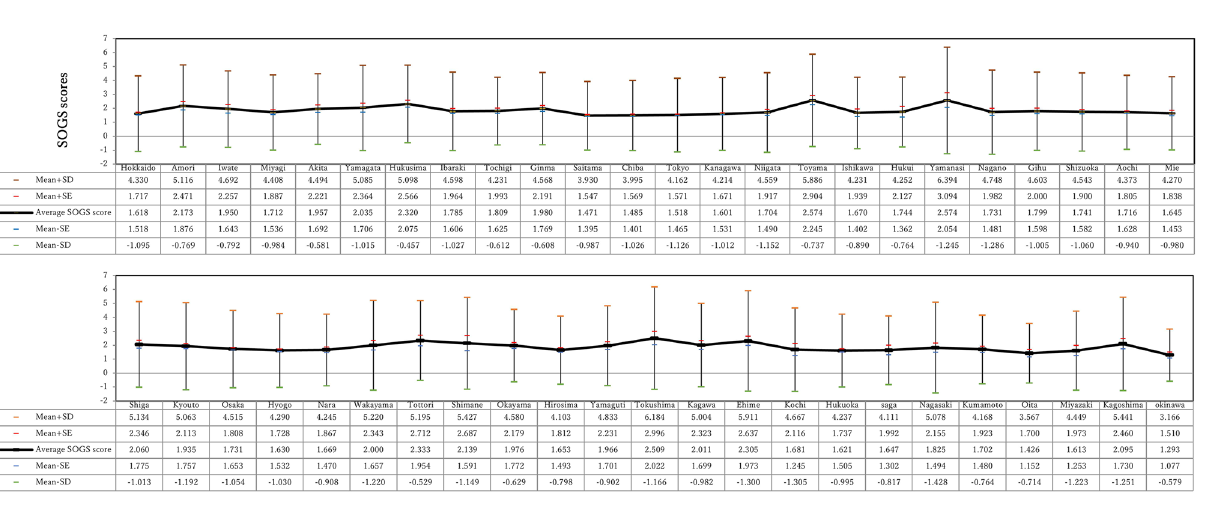
Figure 2. Mean values for each prefecture level.